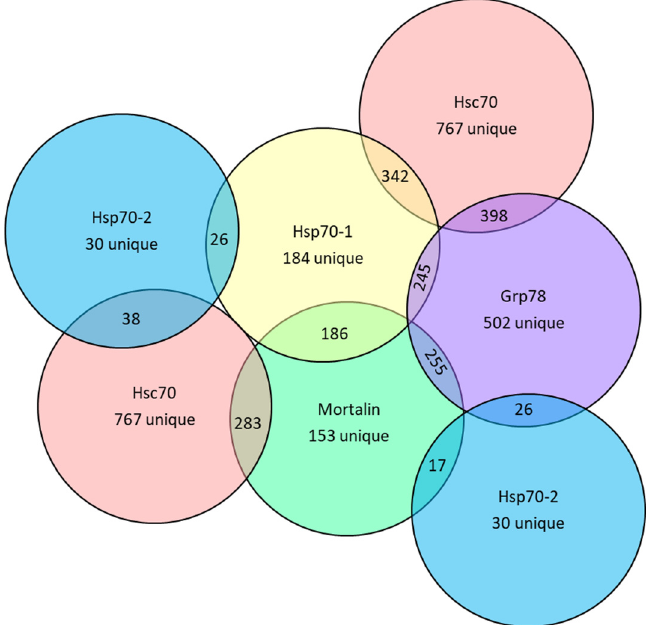
Figure 4. Comparison of protein binding partners for Hsp70, hsc70, Grp78 and mortalin. The numbers inside the non-overlapping, or overlapping, areas of the circles represent the number of direct binding proteins that are unique to the indicated HSPA chaperone, or are common to the adjacent HSPA chaperones, respectively.